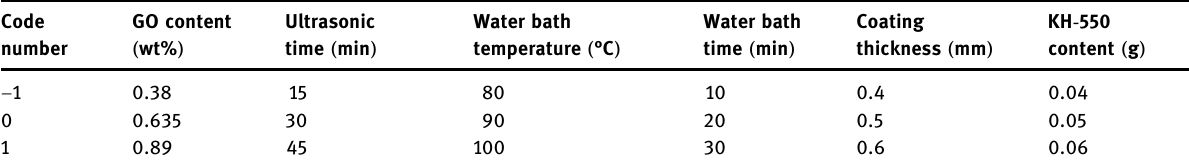
Table 1: Response surface analysis factor level